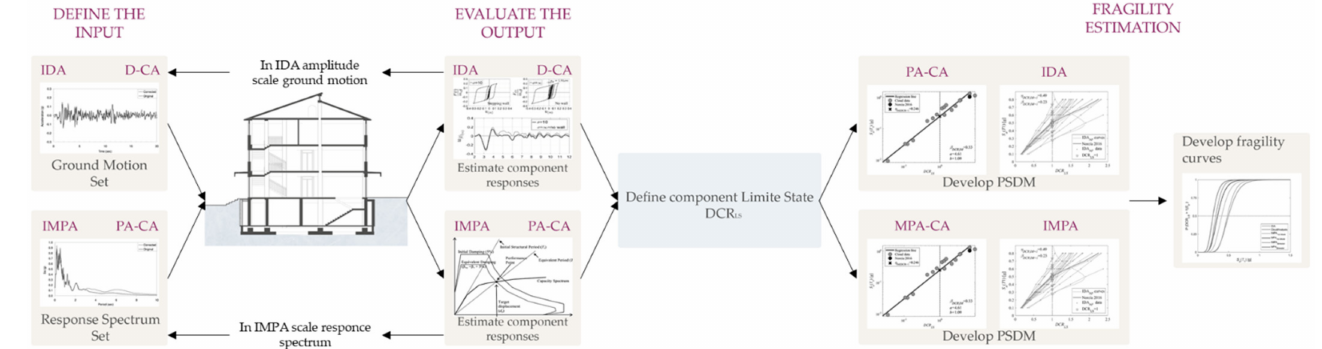
Figure 4. Flowchart schematically shows the main steps to develop seismic fragility curves for nonlinear static and dynamic